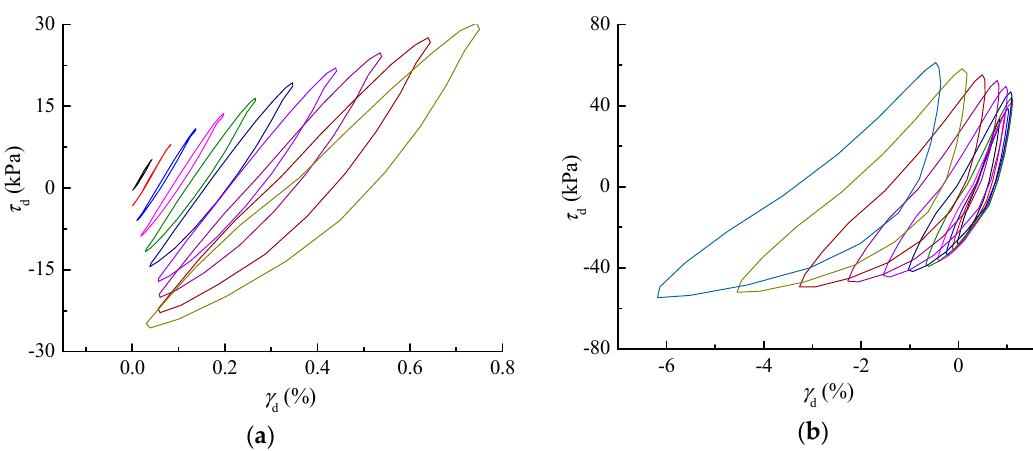
Figure 5. Stress–strain hysteresis loops. ( a ) The fifth cycle of the first 10 loading stages. ( b ) The fifth cycle of 11 to 21 loading stages.